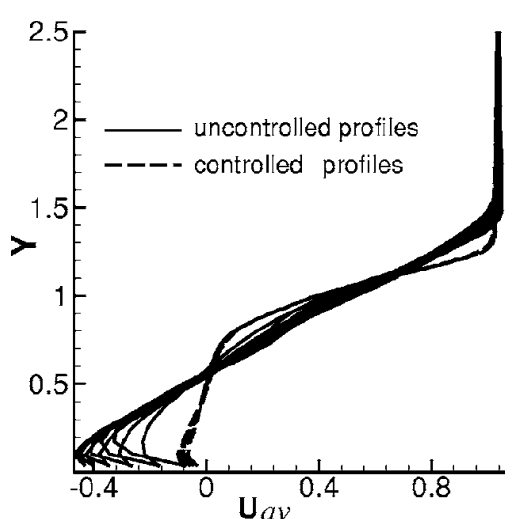
Figure 18. Dimensionless time-averaged streamwise velocity profiles in the last quarter of the cavity 3 < L / D < 4 for the uncontrolled and controlled by the injection and suction with Bc = 1% cases; Re D = 5000; L / D = 4. Note: Y = y / D , U av is the dimensionless time-averaged streamwise velocity (Suponitsky et al.